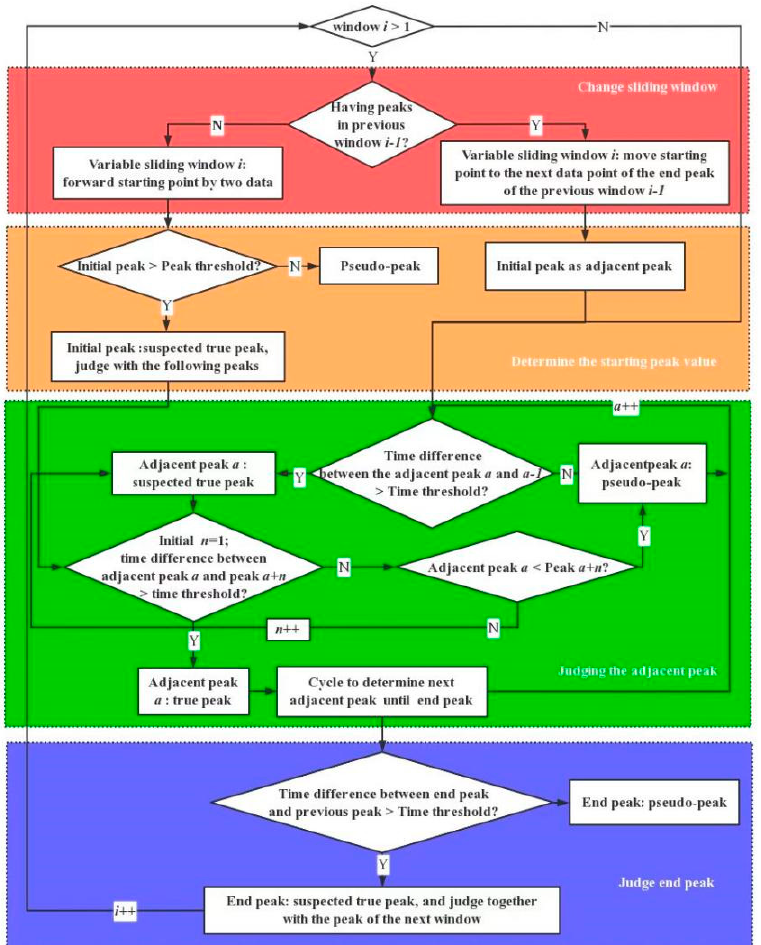
Figure 9. Flow chart of pseudo-peak elimination method with variable sliding window cooperative time threshold.